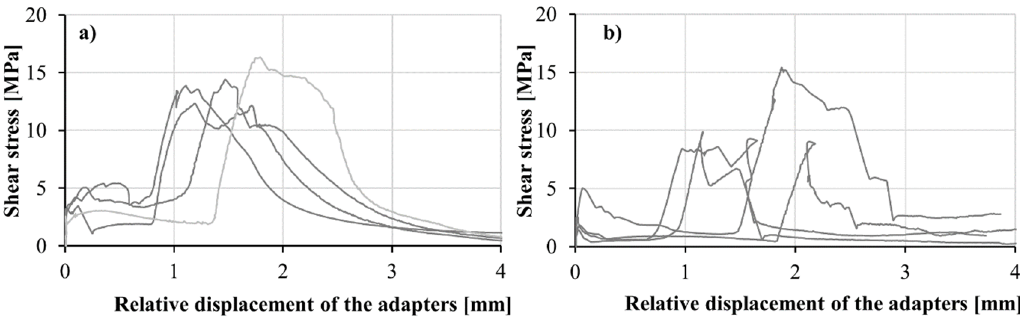
Figure 13. Shear stress vs. displacement curves obtained in the confined quasi-static tests on ( a ) M1-6PE SHCC, and on ( b ) plain M1 matrix.